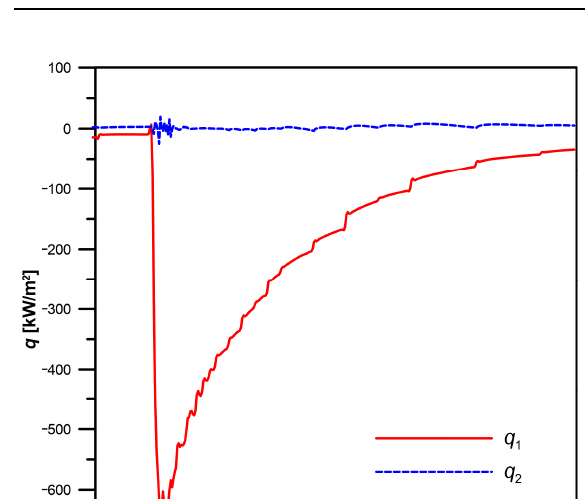
Table 5. Calculation time and errors obtained by the AMI method for two measurement points.